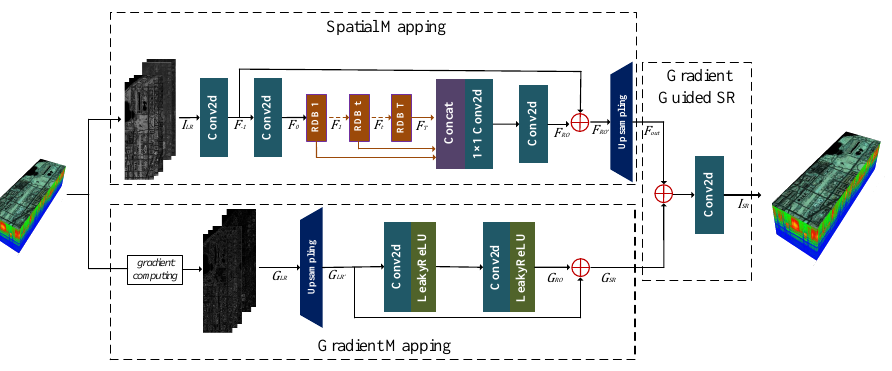
Figure 1. Workflow of the proposed